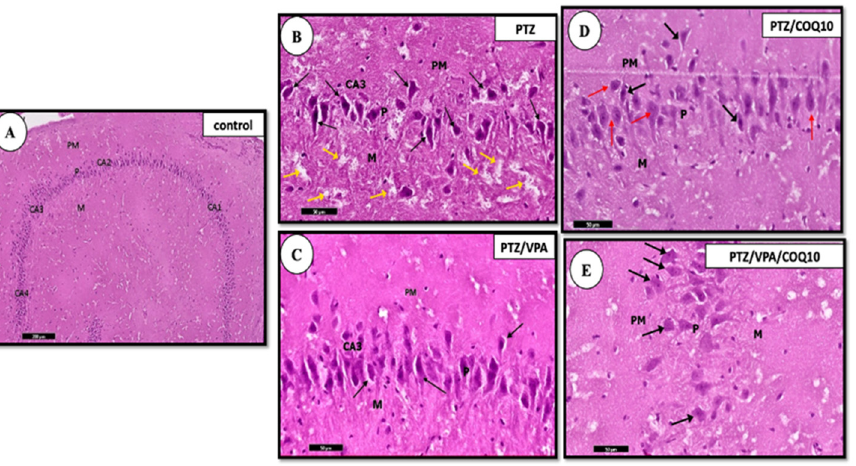
Figure 6. A photomicrograph of a parasagittal section of the hippocampus of all of the rat groups. ( A ) The negative control showing the normal architecture of the hippocampus. ( B ) The PTZ group showing the predominance of the degenerated, deeply stained, shrunken neurons with per neuronal spaces within the pyramidal layer ( ↑ ). Notice the pale, vacuolated areas in the molecular layer (M) suggesting the concurrent swelling/degeneration of the pyramidal cell axons (yellow ↑ ). ( C ) The PTZ/VPA group showing the presence of occasional, deeply darkly stained cells ( ↑ ). ( D ) The PTZ/COQ10 group showing most of the pyramidal cells, which have large rounded vesicular nuclei (red ↑ ). Few deeply stained cells are present with per neuronal spaces (black ↑ ). ( E ) The PTZ/VPA/COQ10 group showing the pyramidal layer which formed of pyramidal cells ( ↑ ) with vesicular nuclei and basophilic cytoplasm. The outer polymorphic layer, PM; the middle pyramidal layer, P; the inner molecular layer, M. Notice the presence of the lateral ventricle (lV). H&E/scale bar 50.